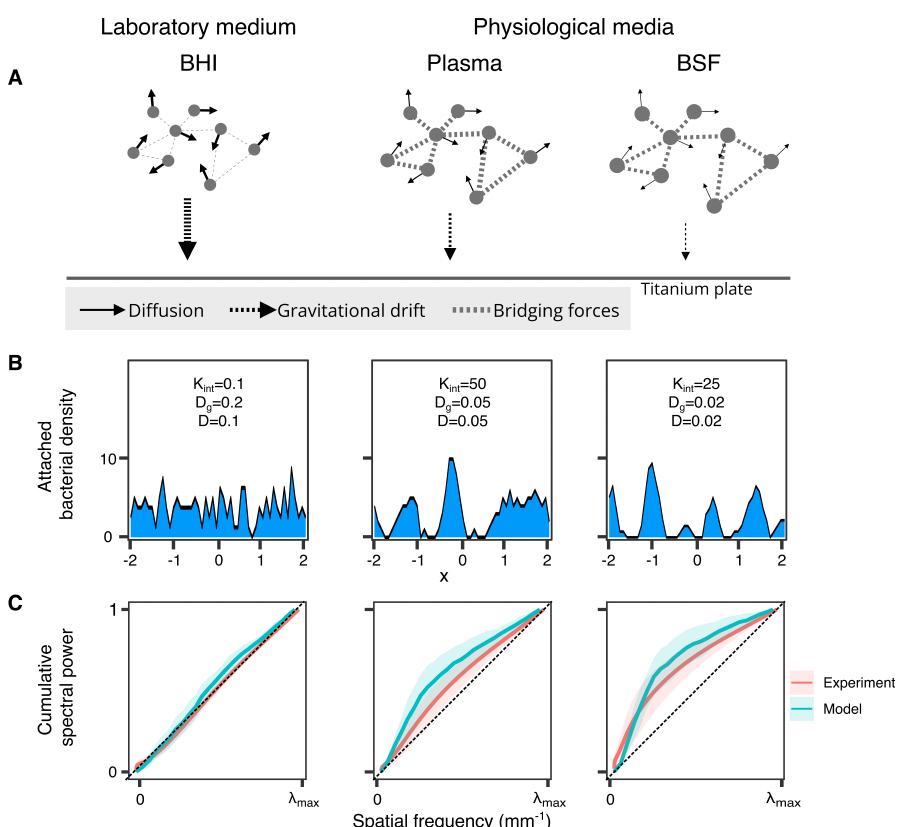
Figure 6. Modeling assumptions, model predictions, and comparison to experimental data. ( A ) Schematic model representation and differences between the simulated media. Thicker arrows or links mean larger physicochemical parameter. ( B ) Simulated sessile biofilm density. ( C ) Comparison between experimentally measured and simulated CSPfs. Thick line and shadow represent the mean and standard deviation of CSPf over replicas, respectively. Experimental CSPfs were averaged over oxygen availability and motion stress conditions. Table 1. Physicochemical determinants of planktonic aggregation.